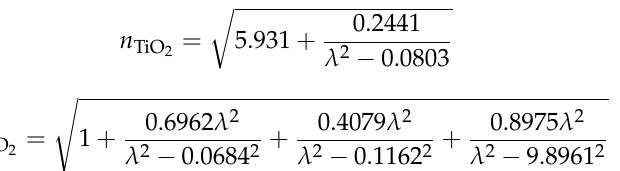
Figure 1. Schematic and structure parameters of the planar Bi 2 Se 3 /DBR integrated with a prism. Wavelength-dependent refractive indices for TiO 2 [26] and SiO 2 [27] as the high and low refractive index materials at a certain wavelength λ are given